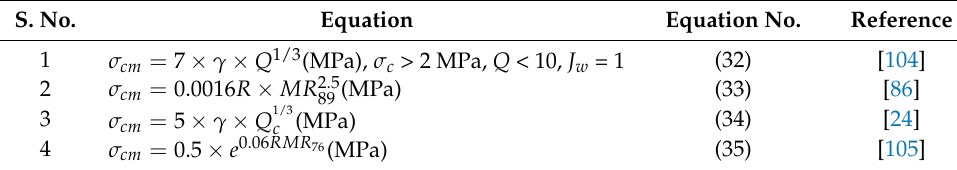
Table 6. Equations for calculation of σ cm without σ c .